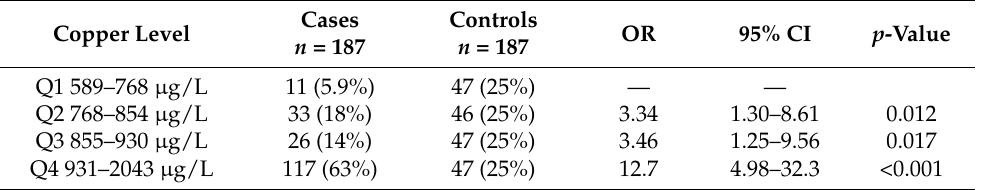
Table 2. Blood copper levels and CRC occurrence.